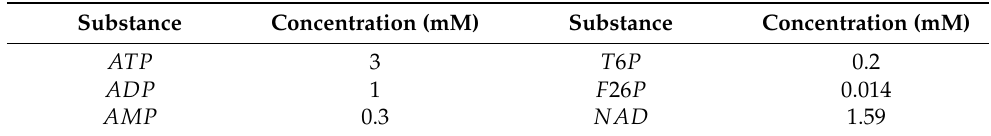
Table 1. Substances with constant concentrations in the model application. Source: van Eunen et al. [16].